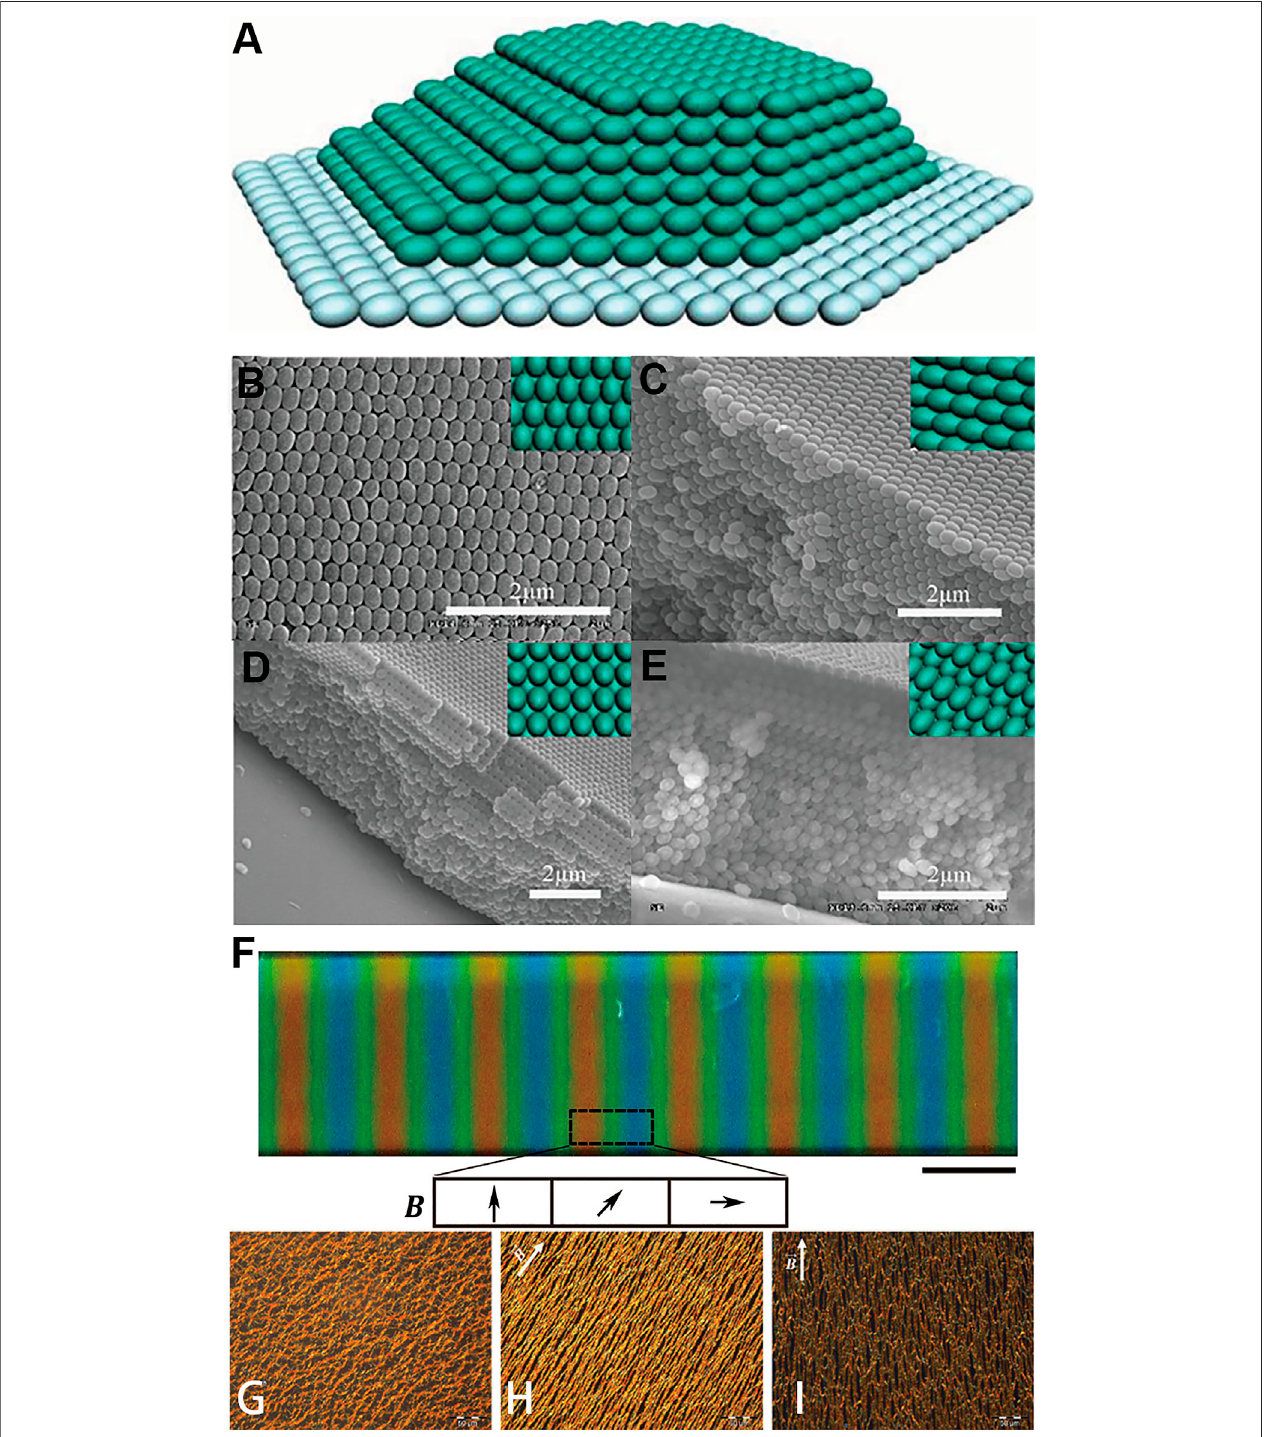
FIGURE 10 | (A) 3D model of an assembled colloidal crystal of ellipsoidal building blocks with the aspect ratio of 1.5; (B – E) SEM images of different crystalline planes.Scalebars:2 mm.The fi gureinsetsshowthemodelsofthecorrespondingcrystallineplanes.ReprintedwithpermissionfromDingetal.(2009).Copyright © 2009 John Wiley and Sons; (F) Digital photo showing the photonic response of nano ellipsoids encapsulated in a fl at glass tube under a non-ideal linear Halbach array. The scale bar corresponds to5 mm. Reprinted withpermissionfrom Wang M. et al. (2015).Copyright © 2015 JohnWileyand Sons; (G – I) Polarized optical microscope images with crossed polarizers showing (G) dispersions of NRs functionalized with PDEGMEMA in excess P(DEGMEMA-b-DOPA), (H) its alignment under an applied external MF; and (I) the rotation of the external MF by 45 ° . The scale bar in all images is 50 mm. Reprinted with permission from Klöckner et al. (2017). Copyright © 2017 Royal Society of